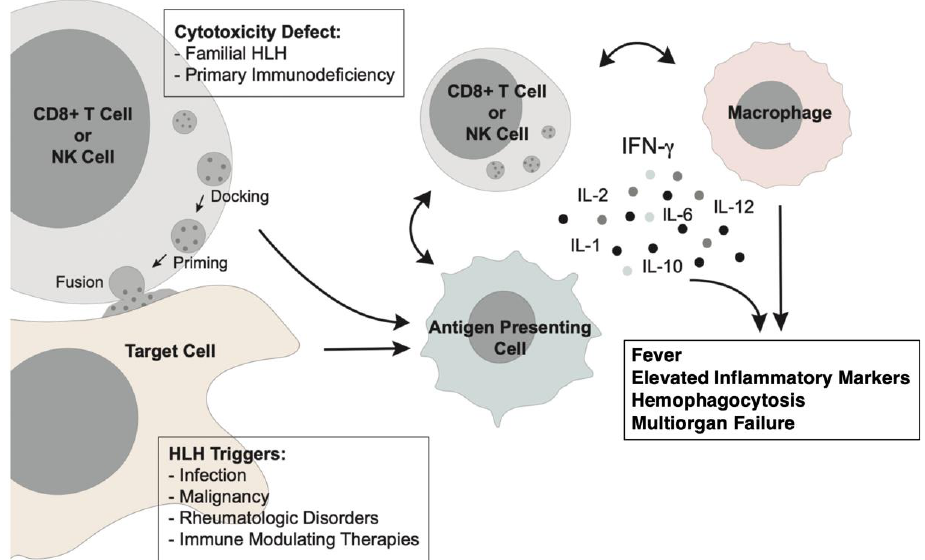
Figure 1. Pathophysiology of HLH [16]. Primary HLH is driven by genetic defects in T or NK cell cytotoxicity, while sHLH is driven by immune hyperactivation against an antigenic trigger. Clinical manifestations arise from a common pathway, resulting in persistent accumulation and activation of CD8 + T cells, NK cells, macrophages, and proinflammatory cytokines, resulting in end-organ damage. Adapted with modifications from Paolino et al. [16], with use, distribution, and reproduction permitted under the terms of the Creative Commons Attribution License (CC BY).